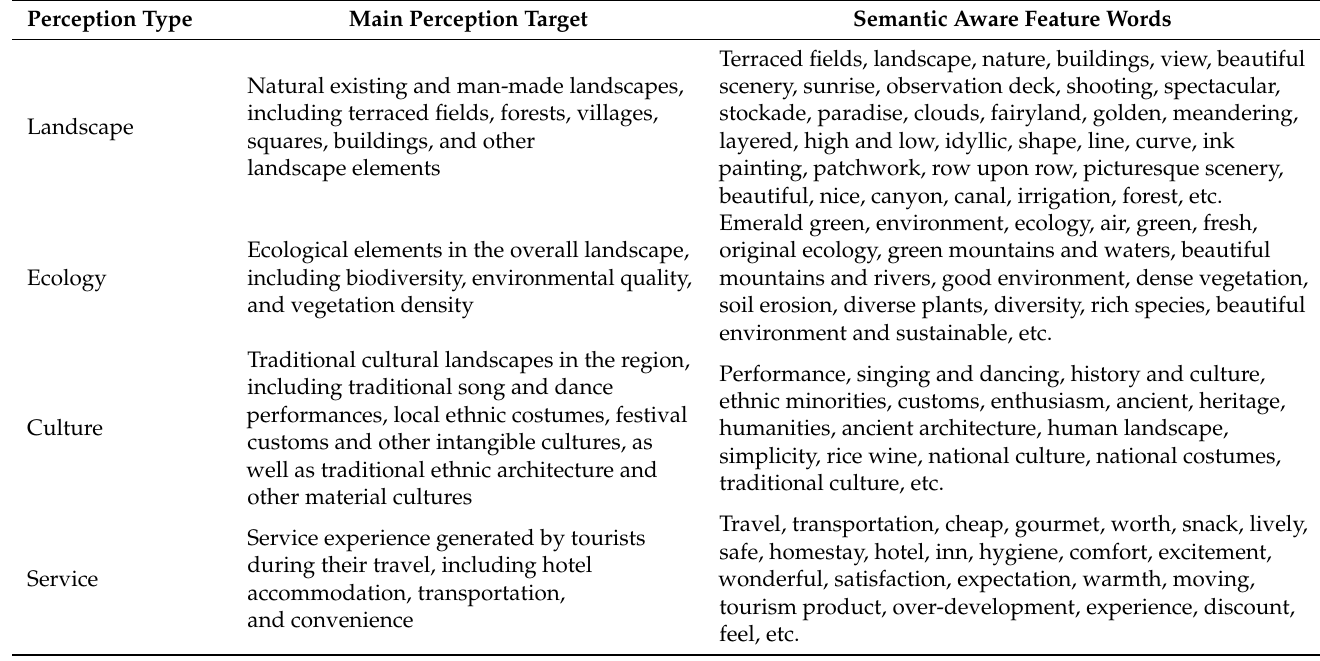
Table 2. Perception type, target, and main semantic feature